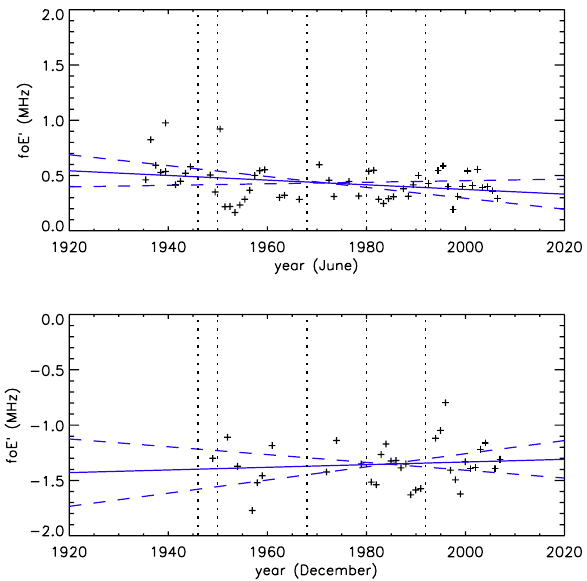
Fig. 7. Values, trends and uncertainties in h 0 E 0 from { May, June and July } (upper panel) and { November, December and January } (lower panel). The trends are as follows: summer, pre-1980, − 0.4km winter, pre-1980, − 1.2km decade − 1 ± 100%; winter, post-1980, − 5.0km decade − 1 ±